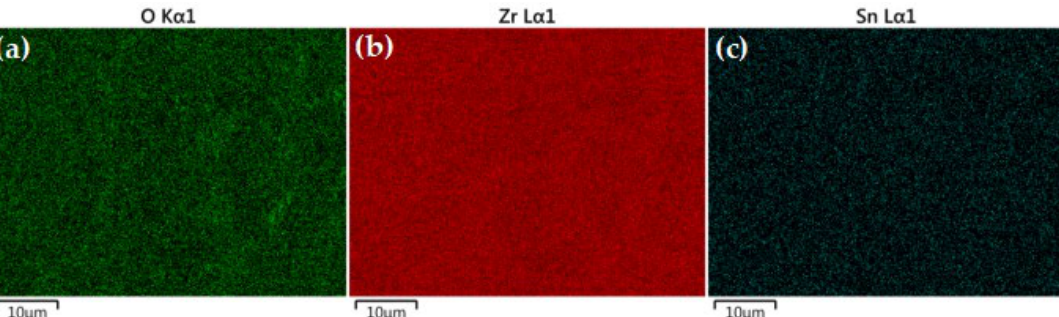
Figure 9. Surface scan of the (FeNi)67Cr15Mn10Al5Ti3 alloy after corrosion in a 360 °C high- temperature and high-pressure water environment for 14 days: ( a ) Distribution diagram of O; ( b ) Distribution diagram of Fe; ( c ) Distribution diagram of Cr; ( d ) Distribution diagram of Mn; ( e ) Distribution diagram of Ni; ( f ) Distribution diagram of Al; ( g ) Distribution diagram of Ti.